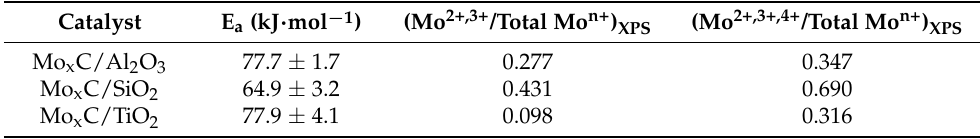
Table 2. Apparent E a determined for Mo x C/support catalysts and surface characteristics determined from